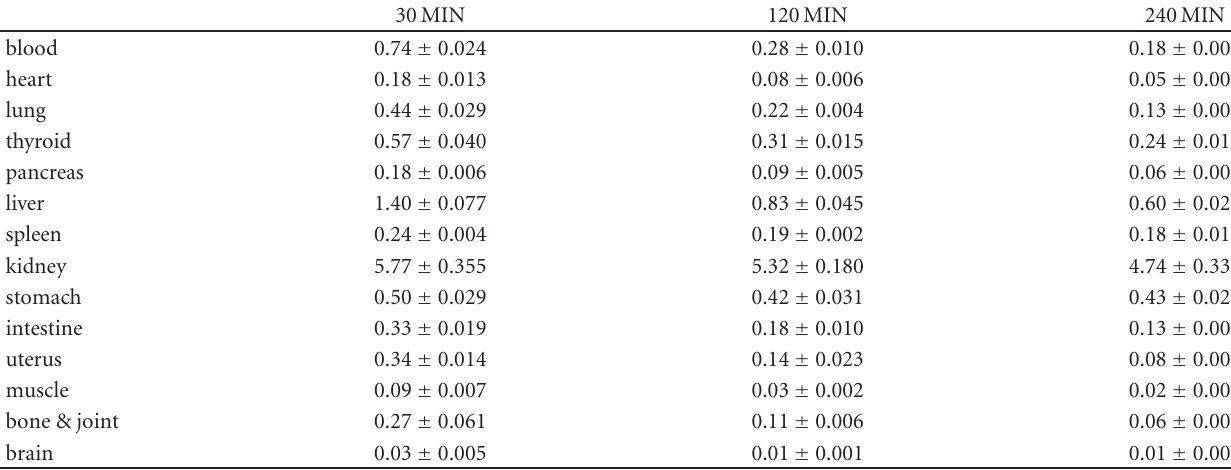
Table 1: Biodistribution of 99m Tc-N4-AMT in Normal Fischer 344